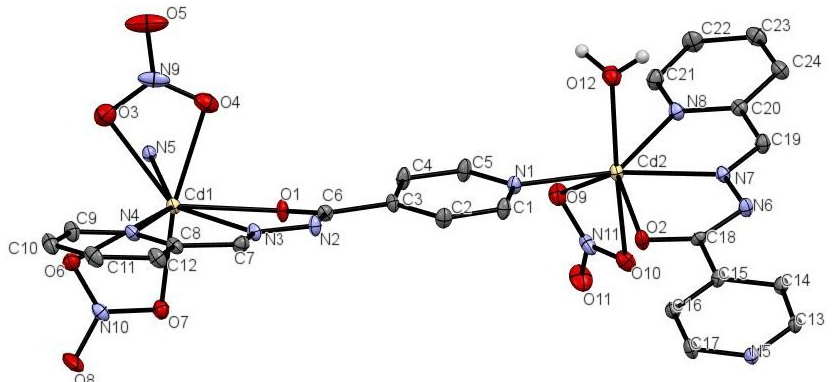
Figure 1. Anisotropic displacement ellipsoid diagram of 1 with a view of coordination environments